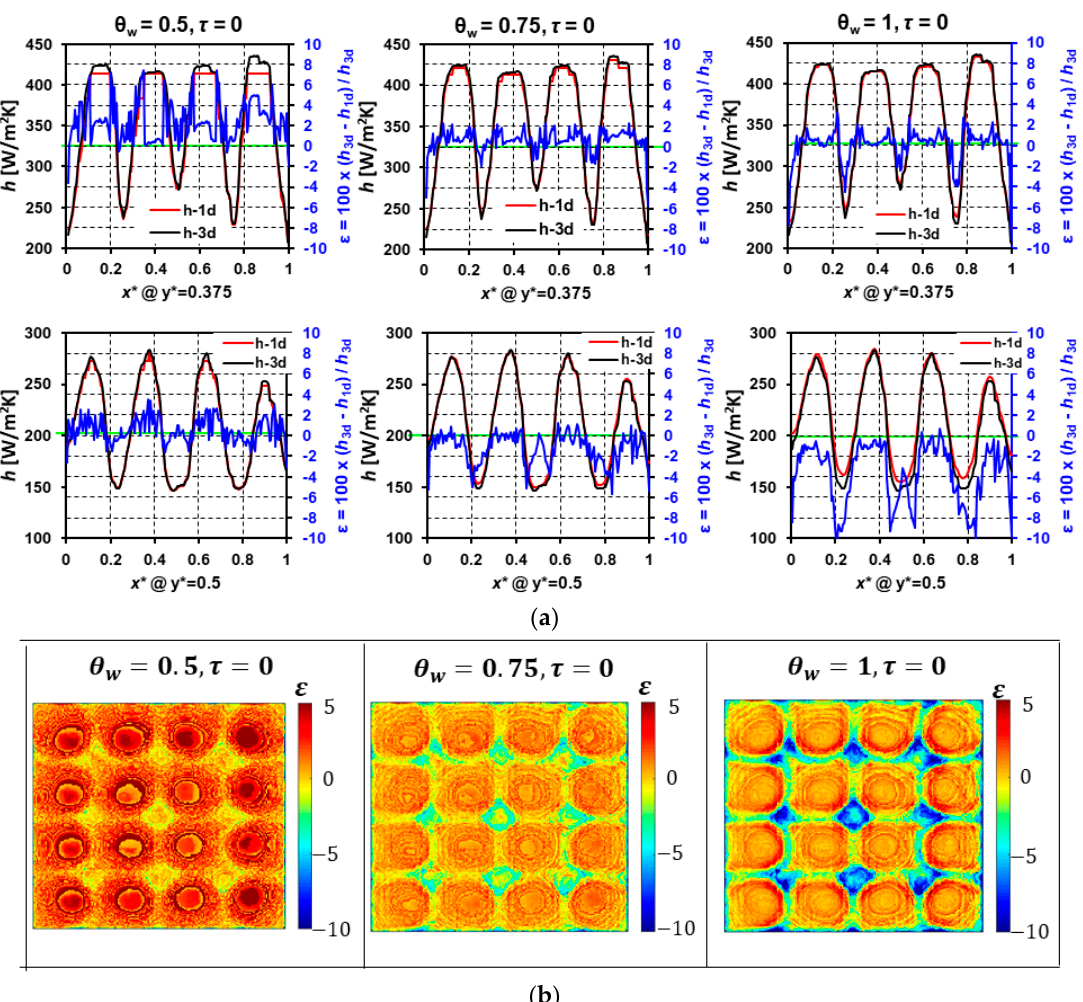
Figure 11. Method B, Case III: ( a ) Local h variation at y* = 0.375 and y* = 0.5 and their relative % differences, ( b ) 𝜀 map for three different wall temperature tracking.